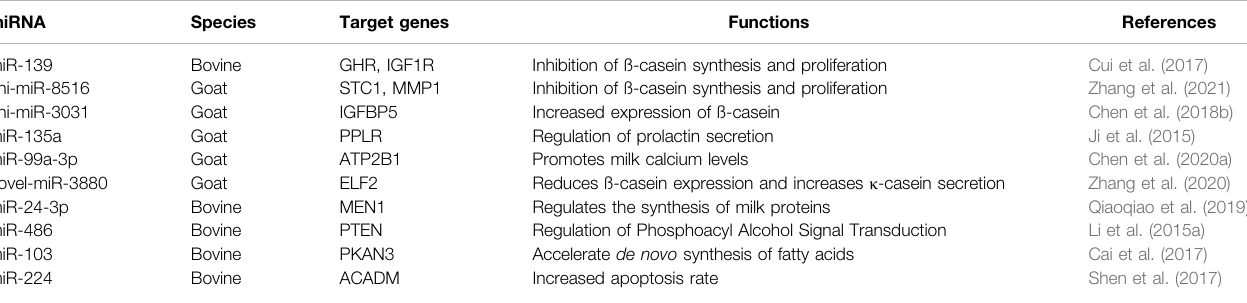
TABLE 3 | MiRNAs regulate other processes in mammary lipid metabolism in ruminants.